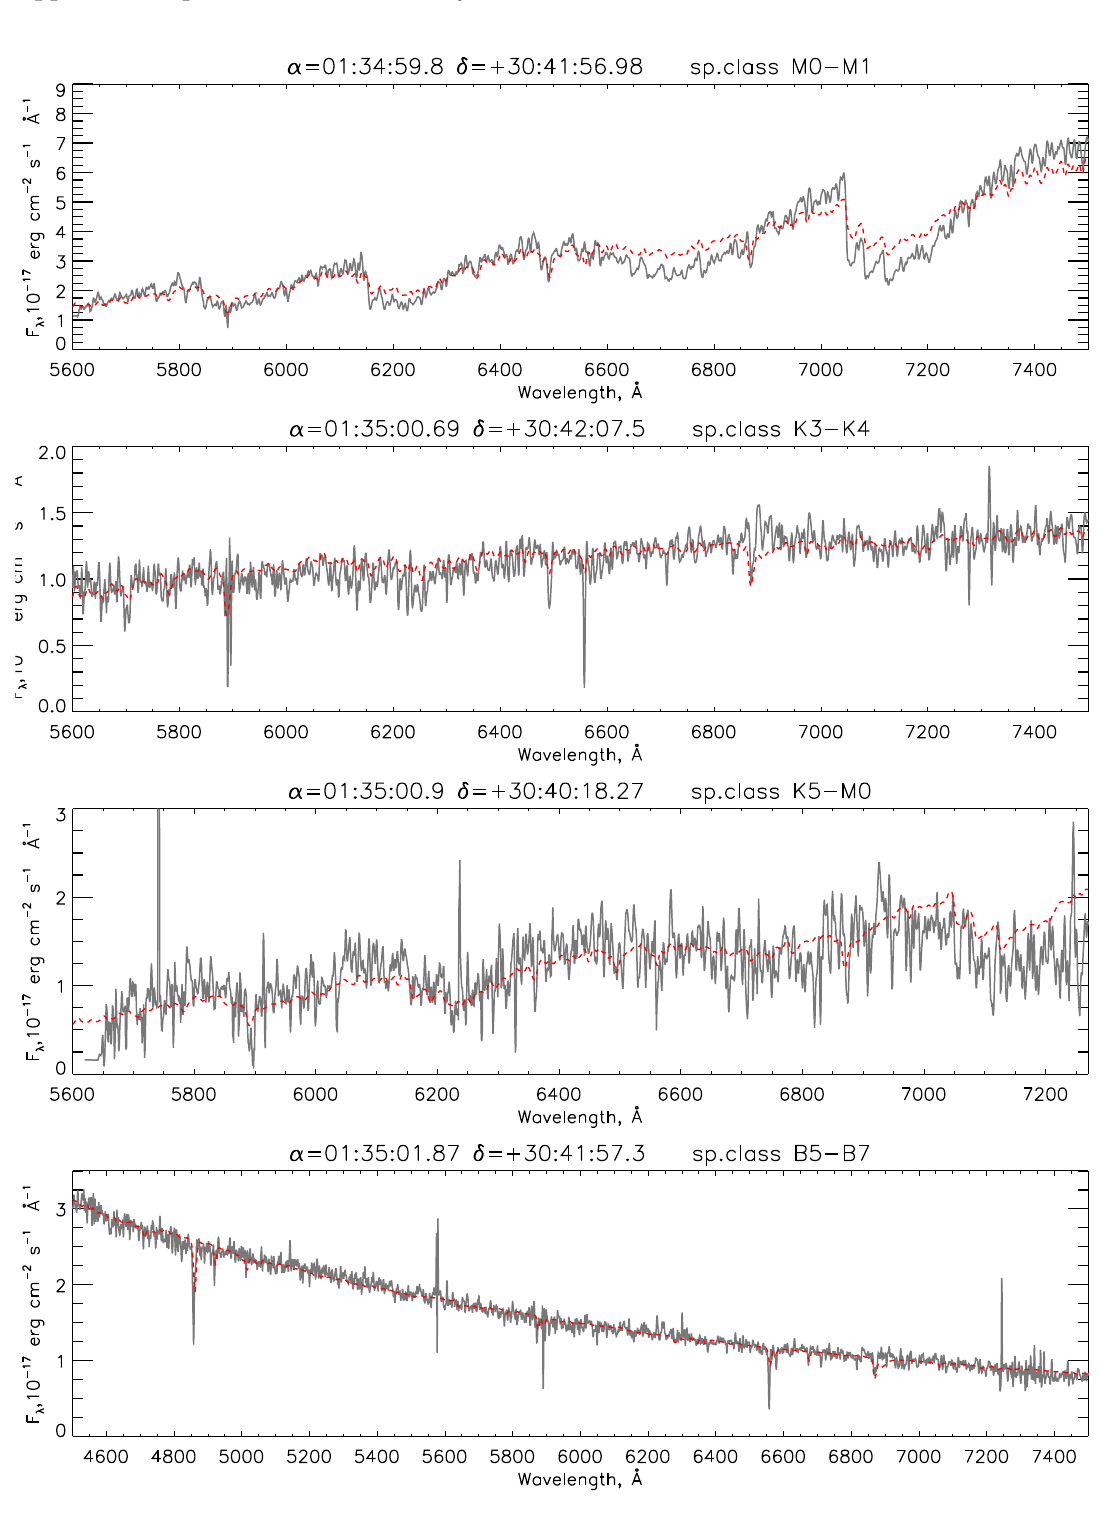
Figure A1. From the top panel downwards, spectra of the stars: J013459.8+304156.98, J013500.69+304207.5, J013500.9+304018.27 and J013501.87+304157.3. For comparison, the reddened spectra of HD42543 (M1Ia-ab), HD154733 (K3III), HD146051 (M0.5III) and HD164353 (B5Ib) are shown by red dashed